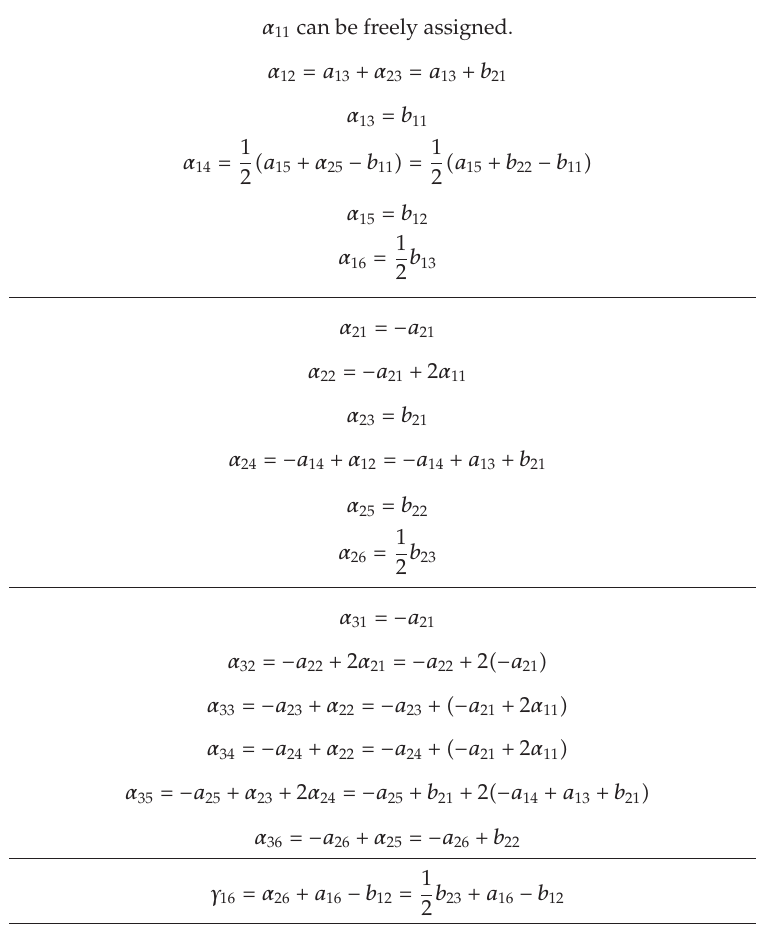
Table 1: Relationships between the coe ffi cients of f (cid:4) 2 (cid:5) (cid:3) z (cid:6) , g (cid:4) 1 (cid:5) (cid:3) z (cid:6) , and ϕ (cid:4) 2 (cid:5) (cid:3) z (cid:6) in (cid:3) A.10 (cid:6) – (cid:3) A.12 (cid:6) , that is, pertaining the quadratic part of the nonlinear transformation (cid:3) 3.7 (cid:6) . α 11 can be freely